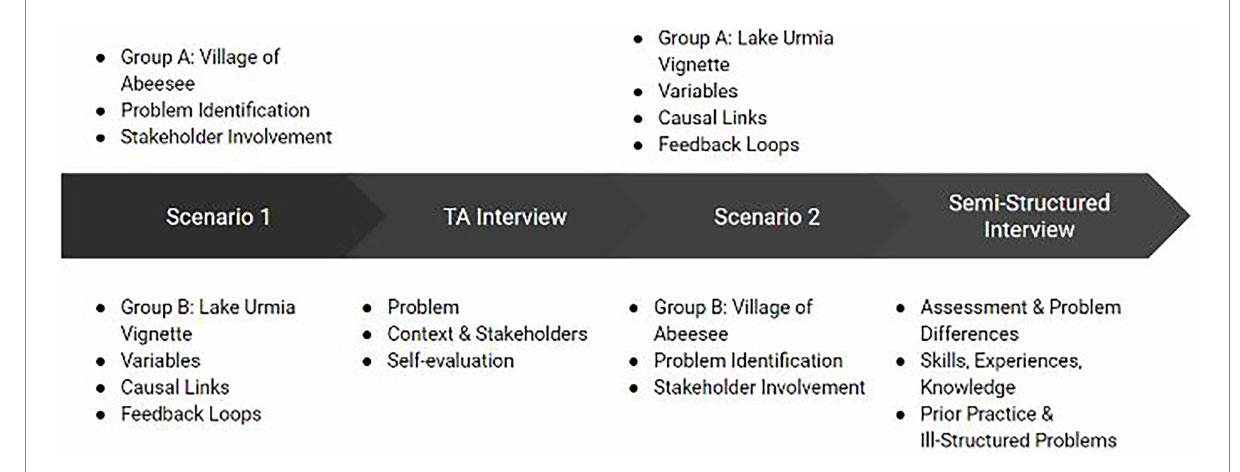
FIGURE 2 Scenario and interview administration